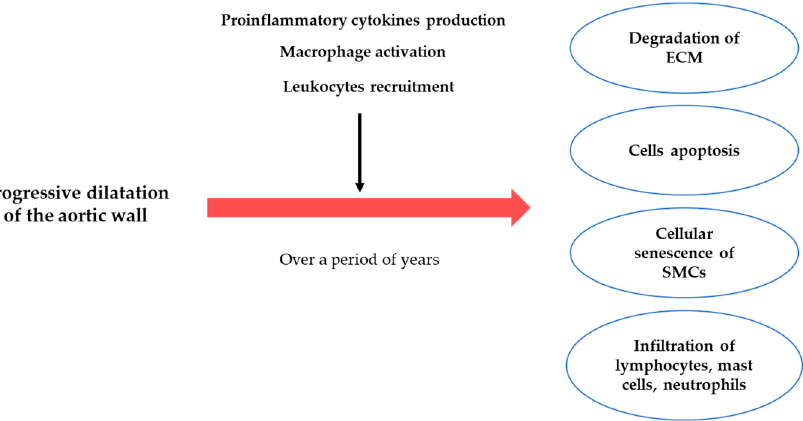
Figure 5. Schematic summarizing of molecular processes underlying abdominal aortic aneurysm formation.